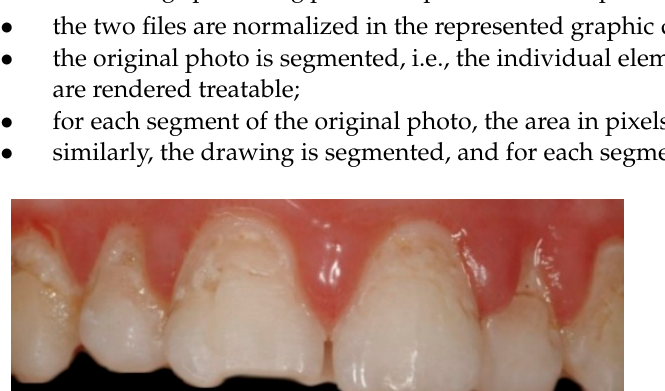
Figure 7. Is the original photo.